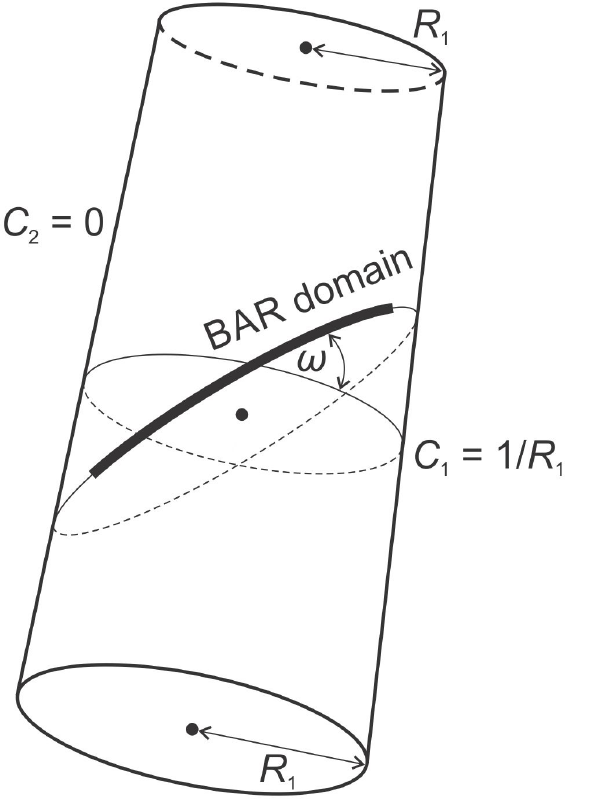
Figure 24. Schematic presentation of the single rod-like BAR domain attached to the cylindrical surface, where R 1 is the radius of the cylinder. Angle ω is the angle of the normal plane in which the BAR domain is lying relative to the normal plane of the first principal curvature C 1 . C 2 is the second principal curvature of the cylinder. Adapted with permission from ref. [18]. 2016